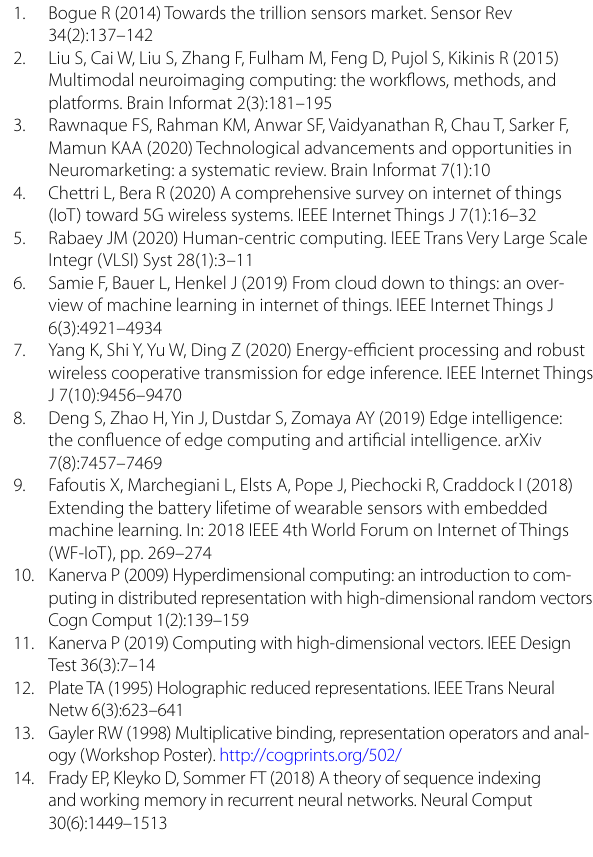
the decoding of bipolarized superpositions, and N-gram encoded vectors, e.g., using resonator networks [50, 51].